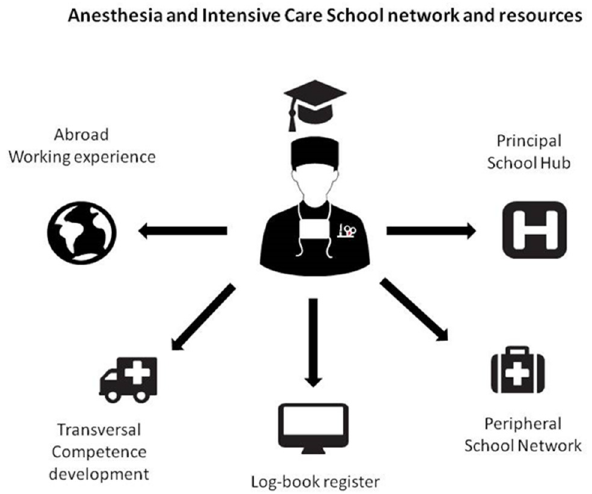
Figure 4. Anesthesia and Intensive Care school network and